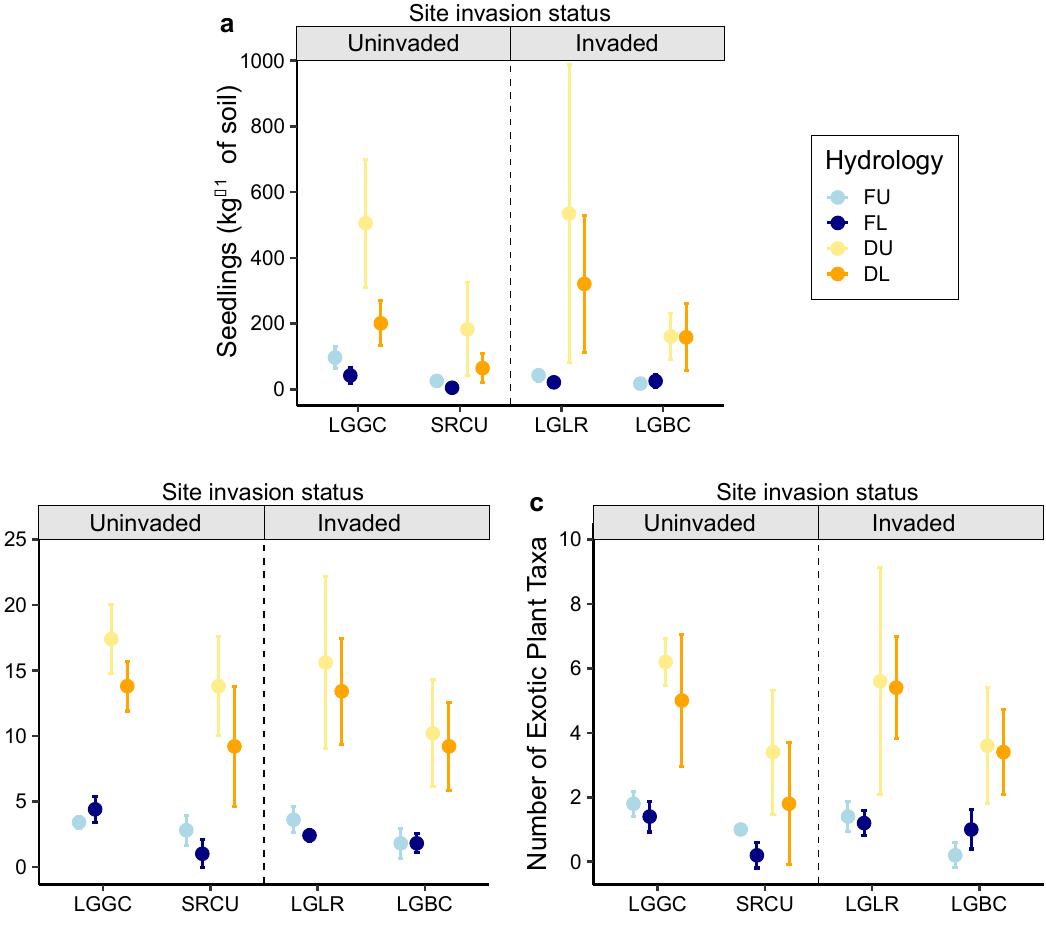
Figure 2. E ff ects of hydrology treatment (F = flooded, D = drawdown, moist soil), depth of soil profile (U = upper / surface; L = lower / buried), and wetland location on a ) total seedling emergence density (seedlings kg − 1 of soil), b ) plant species richness, and c ) exotic plant taxa richness in seed banks from the Laguna de Santa Rosa. Site and species codes are defined in Figure 1. Data points represent means with 95% confidence interval error bars. Some error bars are too small to be visible.